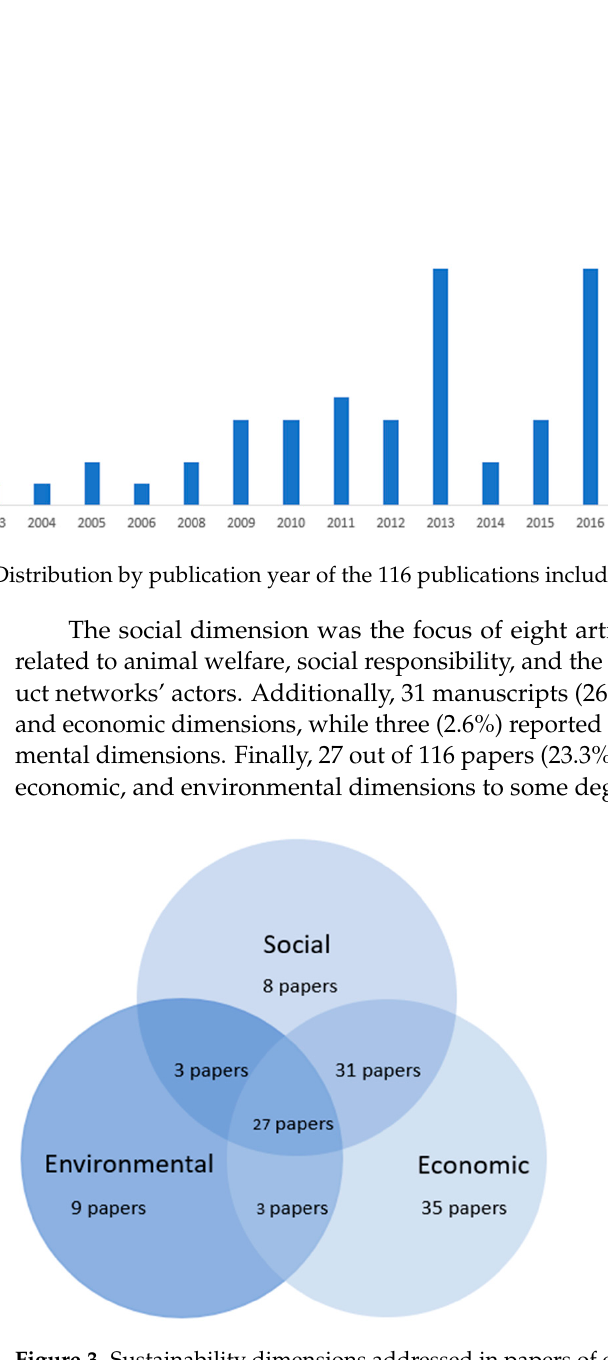
Figure 3. Sustainability dimensions addressed in papers of our sample.